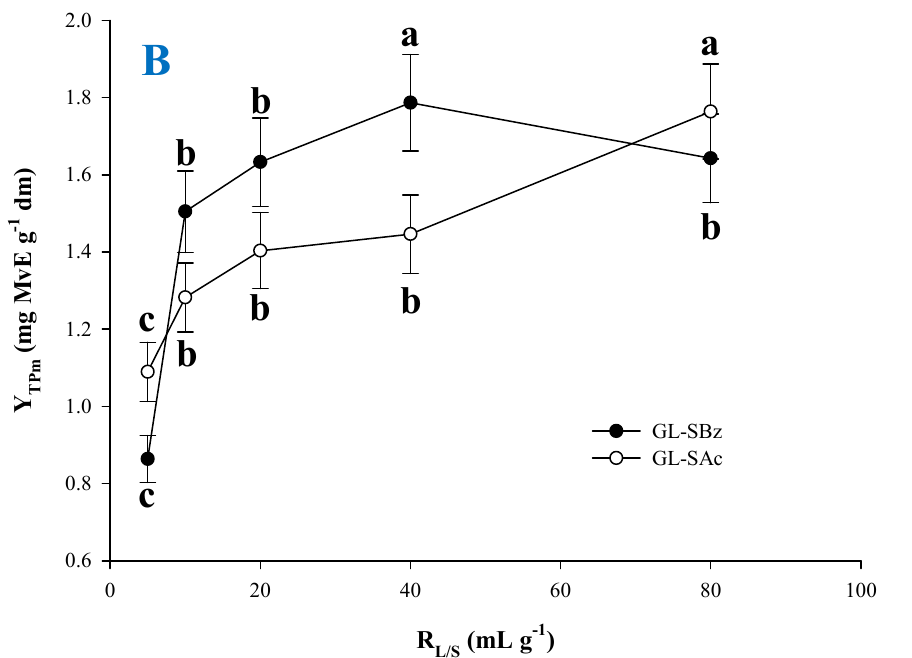
Figure 3. The effect of the R L/S on the Y TP ( A ) and Y TPm ( B ). Samples received ultrasonication pre- treatment for 15 min, with a P = 104.33 W at room temperature (25 ± 2 °C). After pretreatment, batch stirred-tank extractions were performed at 50 °C and 500 rpm for 150 min. Letters a, b and c signify statistical difference ( p < 0.05).